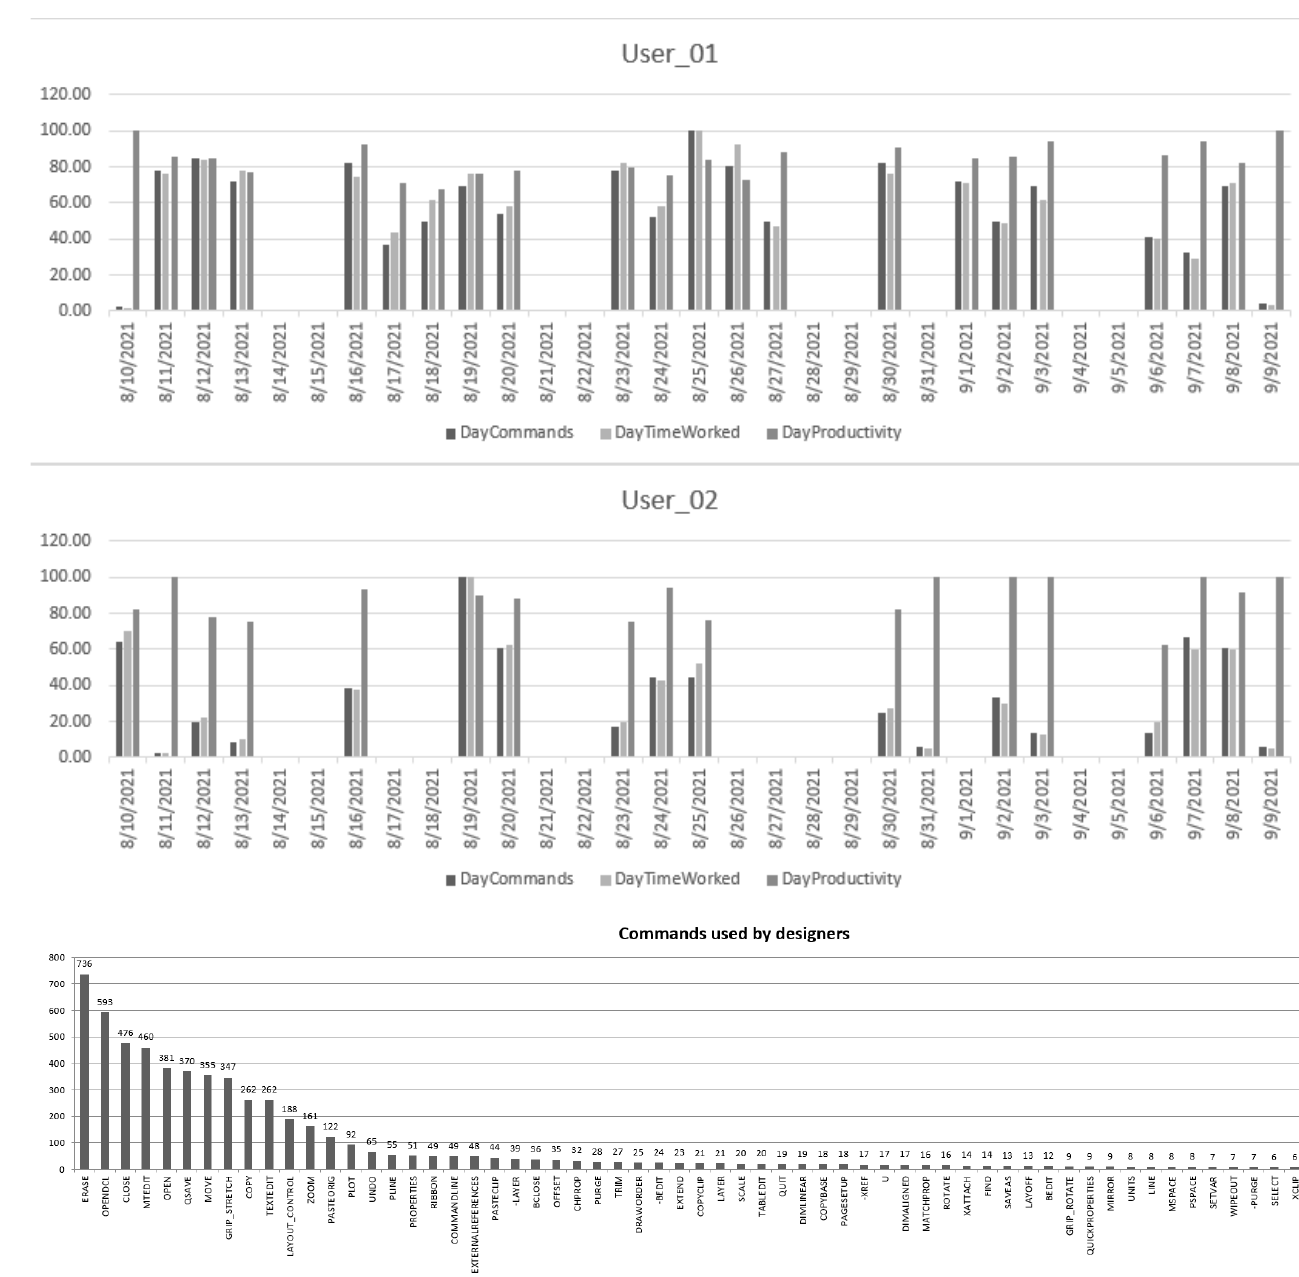
Fig. 4. Commands, working time and productivity metrics shown by bar